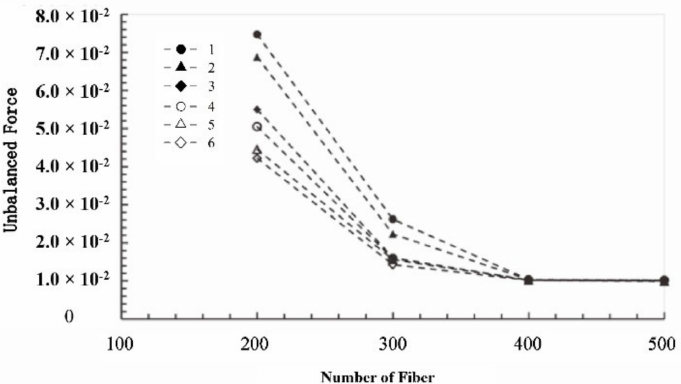
Figure 8. The relationship curves between unbalanced force and number of fibers for different viscosity grade (the symbols stand for the viscosity